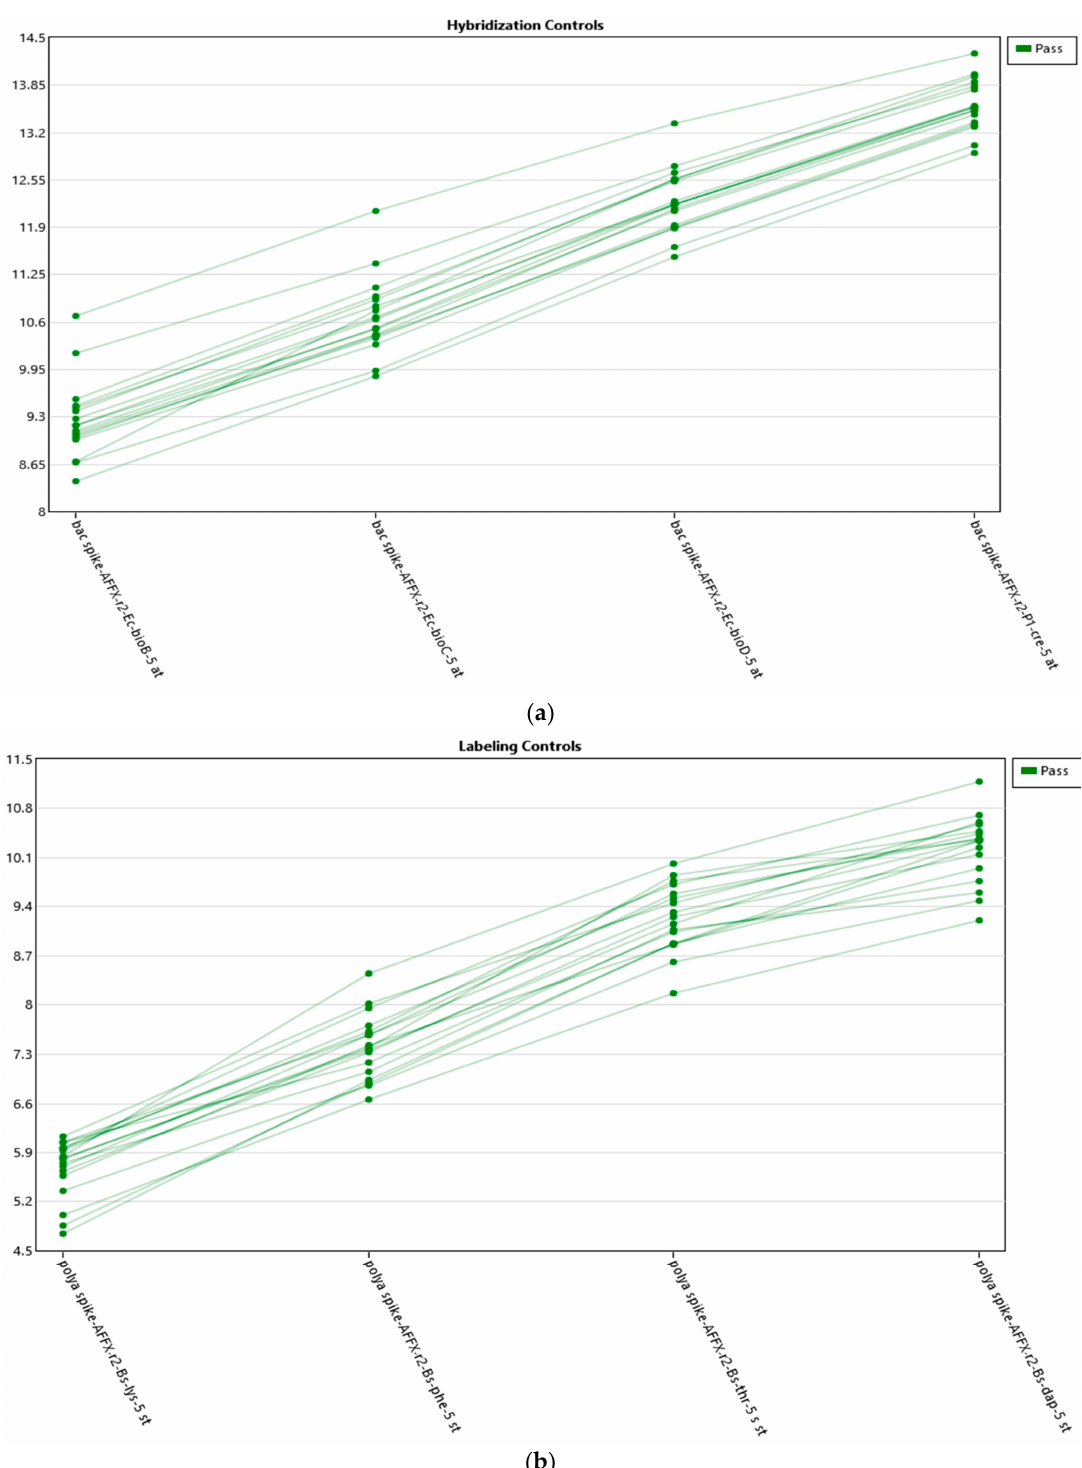
Figure 1. ( a ) Hybridization controls. Graphs on the quality controls provided by the platform, indicating that the experiment has been conducted correctly. ( b ) Labeling controls. Graphs on the quality controls provided by the platform, indicating that the experiment has been conducted correctly.